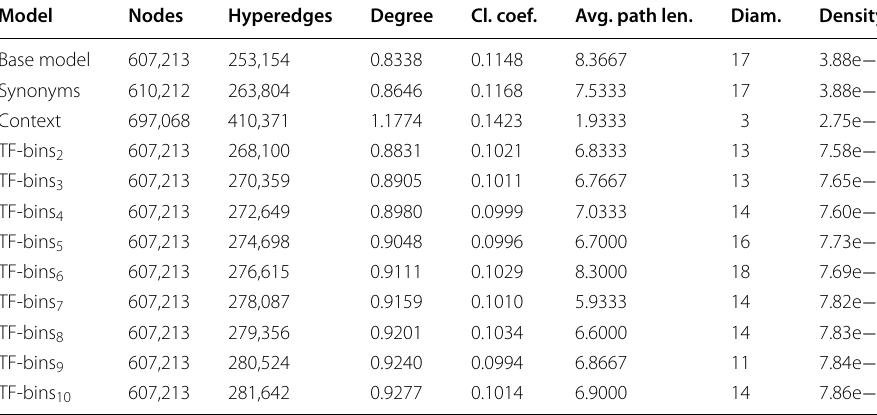
Table 7 Comparing the global statistics for the different models